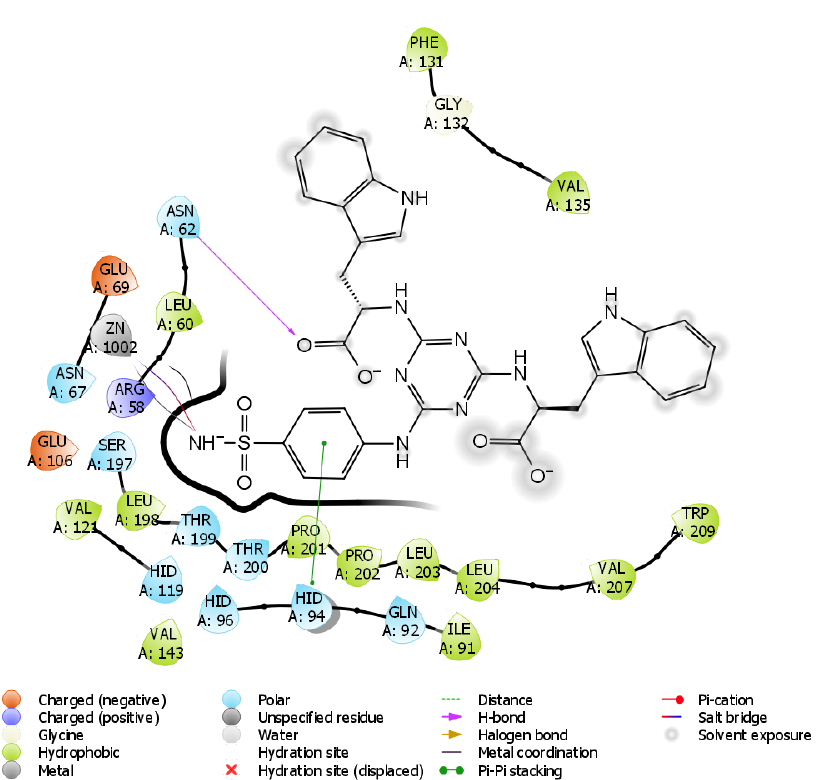
Figure 1. Molecular surface of the binding site of hCA II with docked compound 6 (Trp derivative).